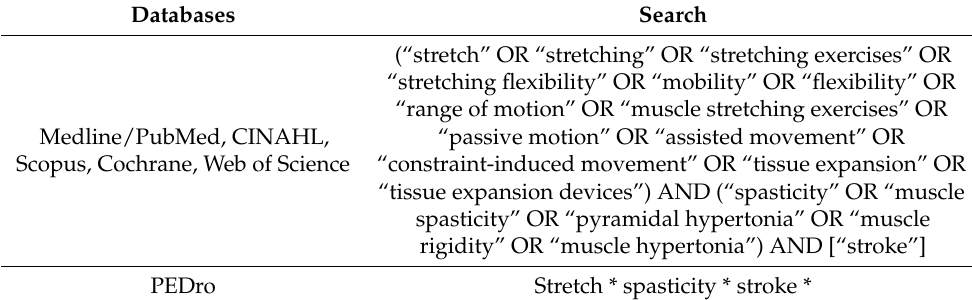
Table 1. Research strategy for the different databases. Databases Search